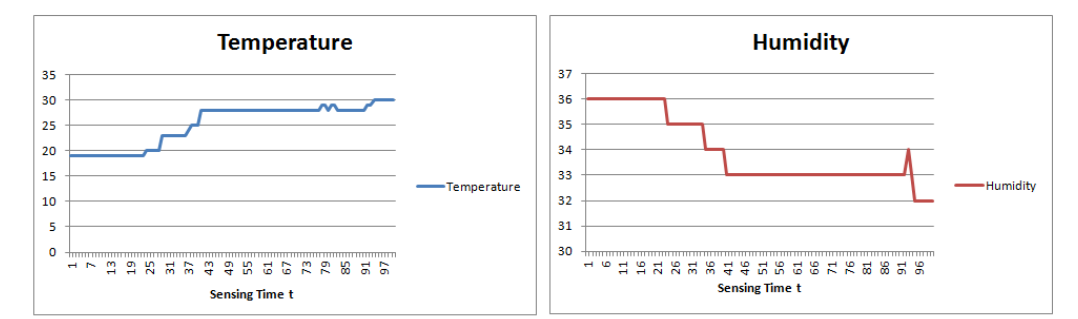
Figure 13. Data acquired by the ESA when executing the monitoring